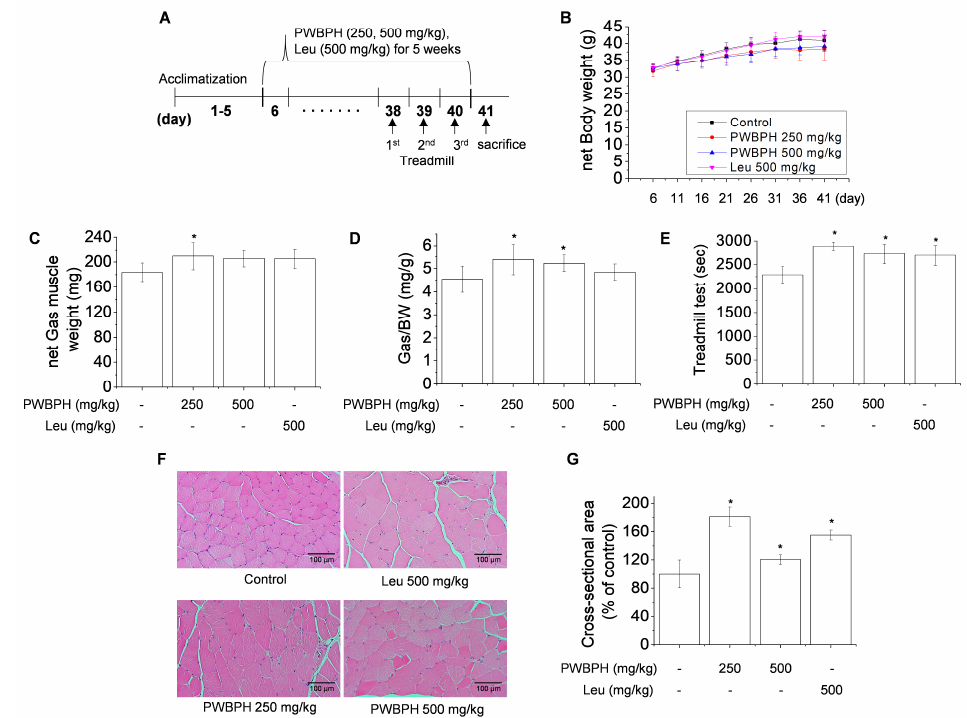
Figure 1. Effects of PWBPH supplementation on muscle mass and exercise function. ( A ) Schematic diagram of the experimental protocol in mice. ( B ) Body weights are shown ( n = 6). ( C , D ) Net gastrocnemius (Gas) muscle weight and Gas muscle/body weight ratios in the 4 groups of mice are shown ( n = 6). ( E ) Exercise function was determined based on the time to exhaustion in the forced treadmill exercise test ( n = 6). ( F ) Representative histological images of the Gas muscle stained with hematoxylin and eosin are shown (100× magnification). ( G ) The myofiber cross-sectional area (CSA) was analyzed using Image J software ( n = 3). Data are shown as the means ± SD. * p < 0.05 vs. control group.